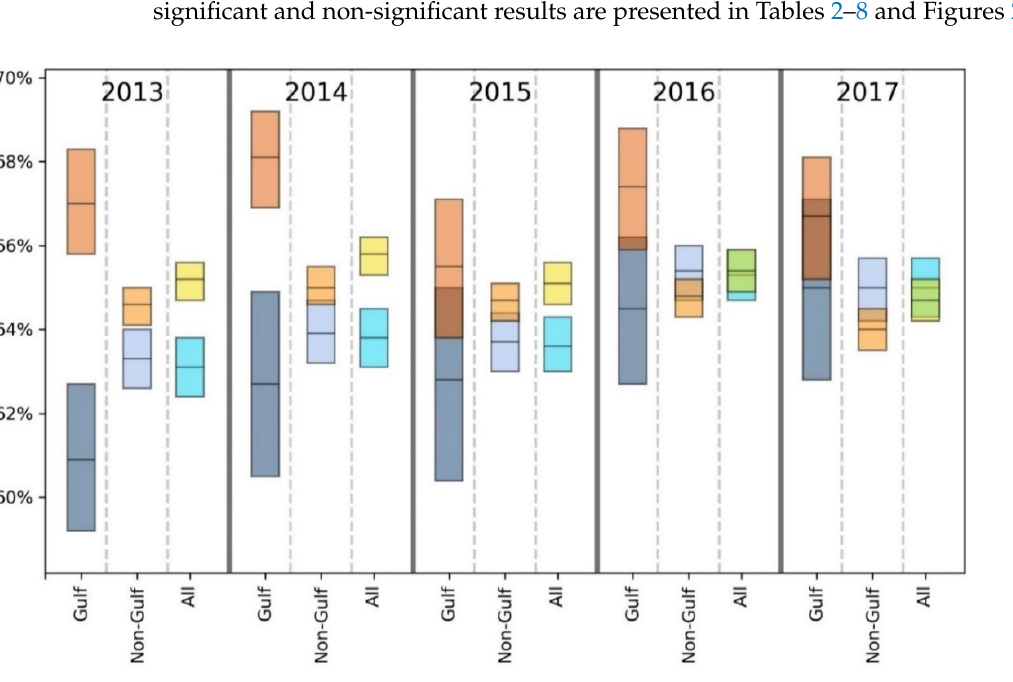
Figure 2. Comparison of mean (black line across bar) and 95% confidence intervals for percentages of Gulf and non-Gulf MMSA respondents reporting zero physically unhealthy days out of the last 30. Colors denote the following: dark blue = coastal Gulf, light blue = coastal non-Gulf, dark orange = non-coastal Gulf, light orange = non-coastal non-Gulf, bright blue = all coastal, yellow = all non-coastal.